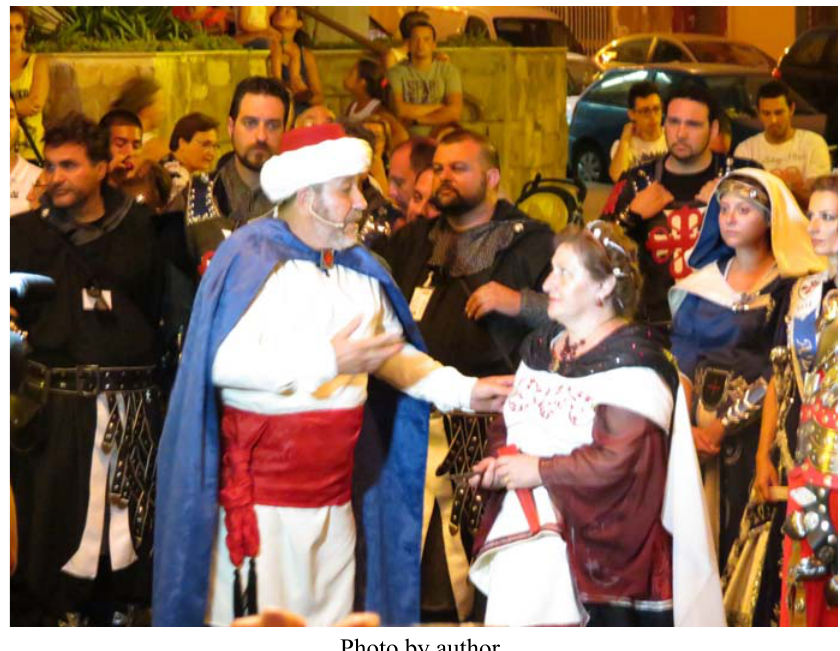
Figure 8. After the “reconquest,” the Moor emir pleads for mercy from the Christian queen. San Blas neighborhood, Alicante city, 9 July